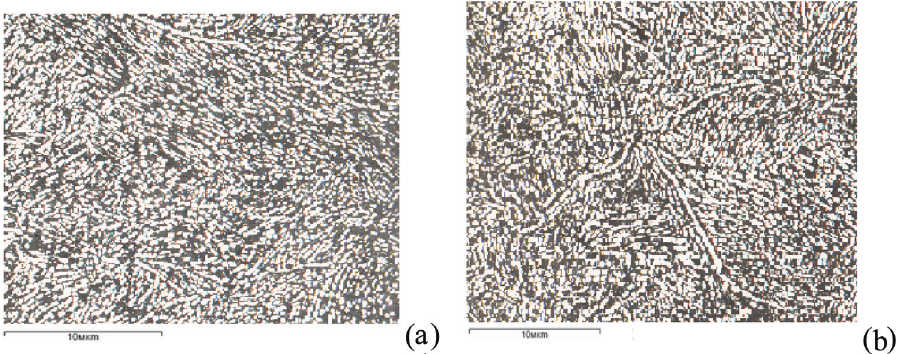
Figure 13: Microstructure of forgings from BT9 alloy after a broach in β -, ( α þ β )-, β -areas (a) in the cross section of forging; (b) in the longitudinal section of